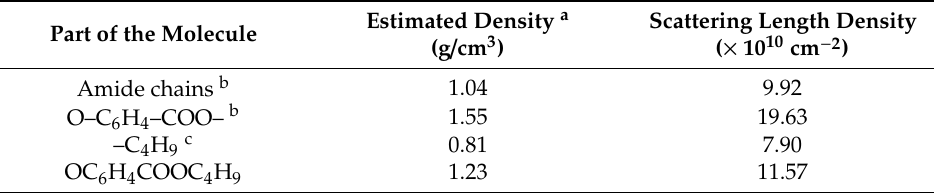
Table 2. Estimated densities and scattering length density of different parts of HUB-4. Part of the Molecule